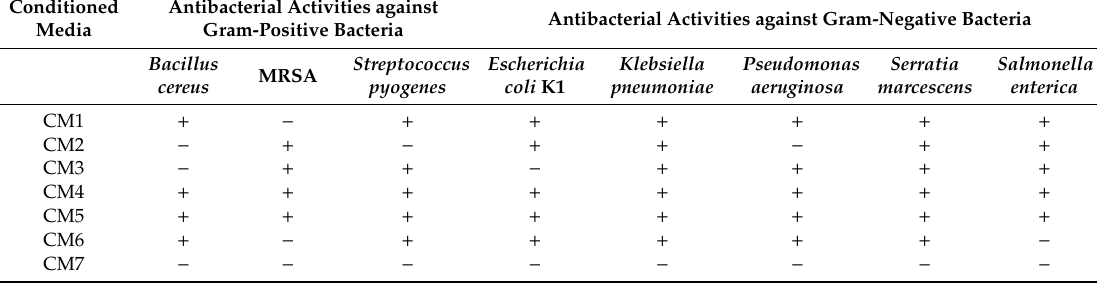
Table 2. Representation of CM antibacterial activities against Gram-positive and Gram-negative bacterial pathogens.